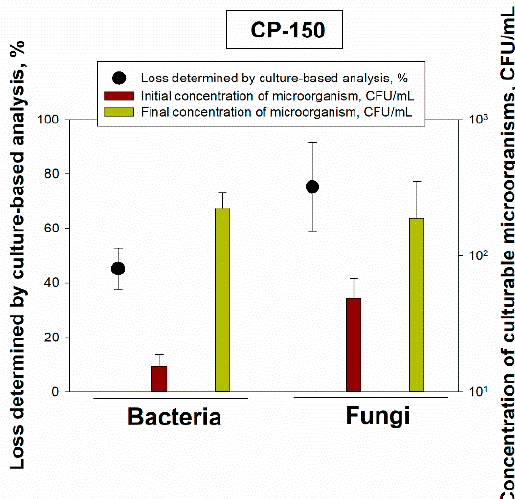
Figure 6. Losses of the culturable microorganisms in the outdoor environmental samples that were concentrated from 20 mL initial liquid using the CP-150 at the elution fluid volume setting M and using 3 consecutive elutions. Outdoor bioaerosol samples were collected using a BioSampler (SKC Inc.) with 20 mL collection liquid for 120 min. The data represent the averages of three repeated measurements, and the error bars represent one standard deviation.